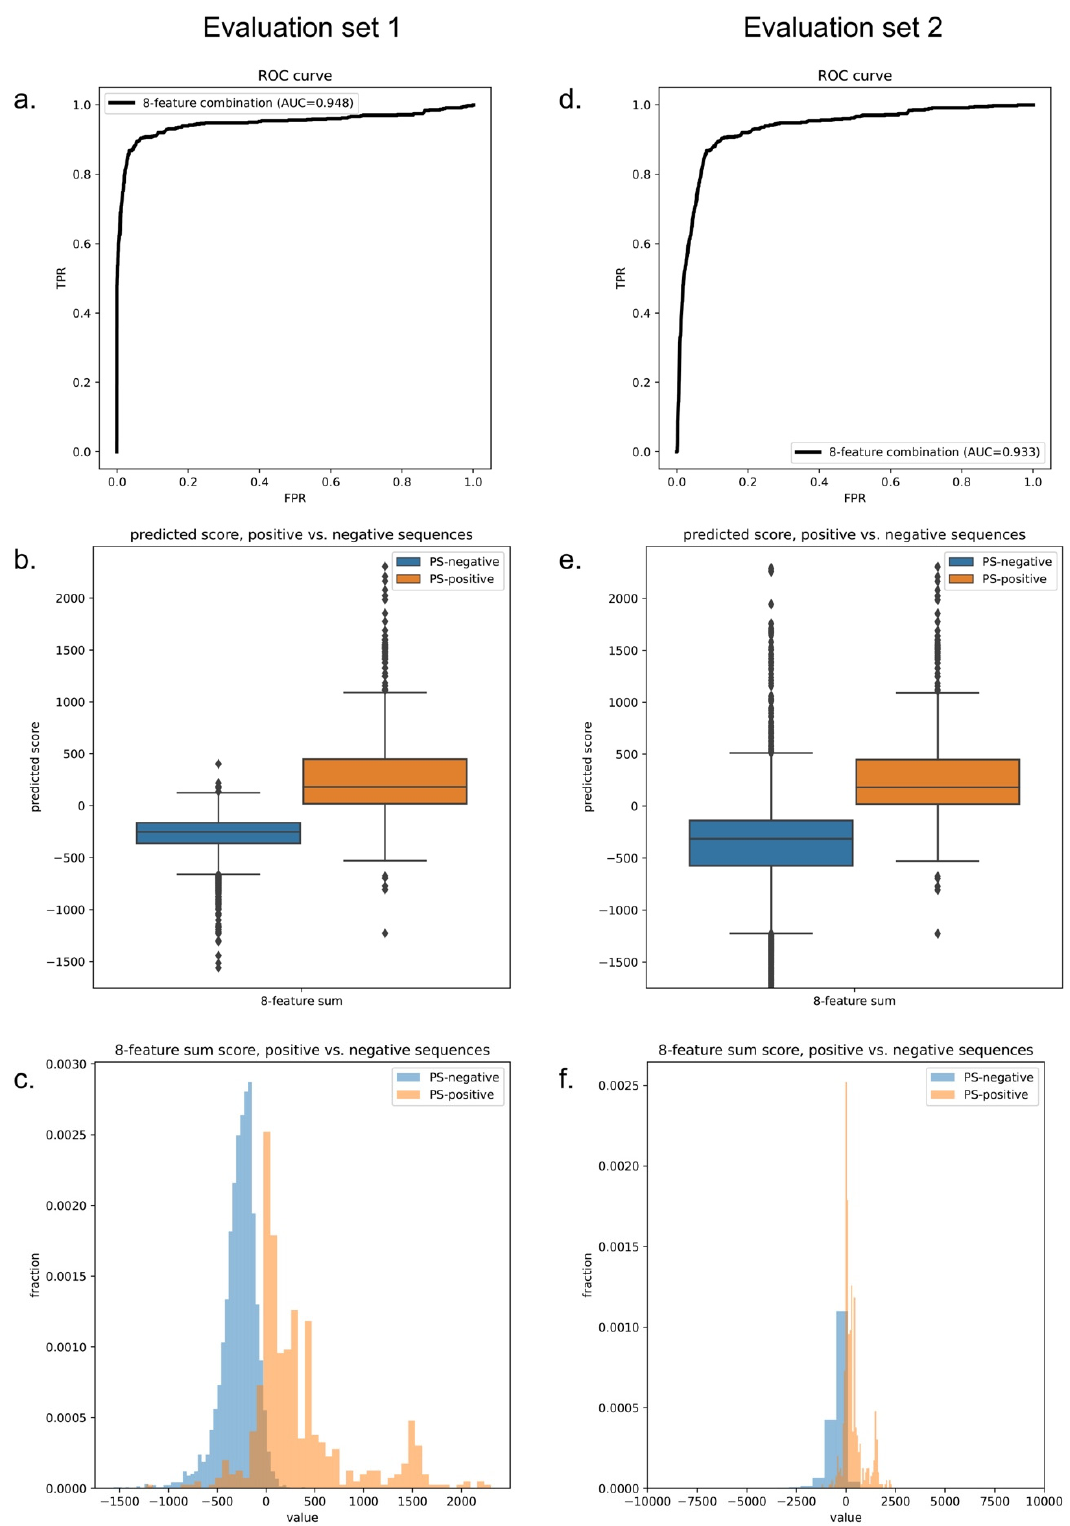
Figure 6. Final predictor of model performance. Performance plots of the final human + PDB model on evaluation set 1 (left, PS-positive sequences and the entire PDB proteome) and evaluation set 2 (right, PS-positive sequences and the entire human proteome). ( a , d ) ROC curves. ( b , e ) Predicted score boxplots of positive vs. negative sequences. ( c , f ) Distribution histograms of positive vs. negative sequences.